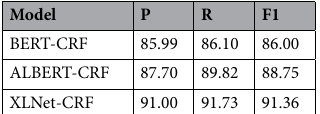
Table 4. Evaluation results of pretraining